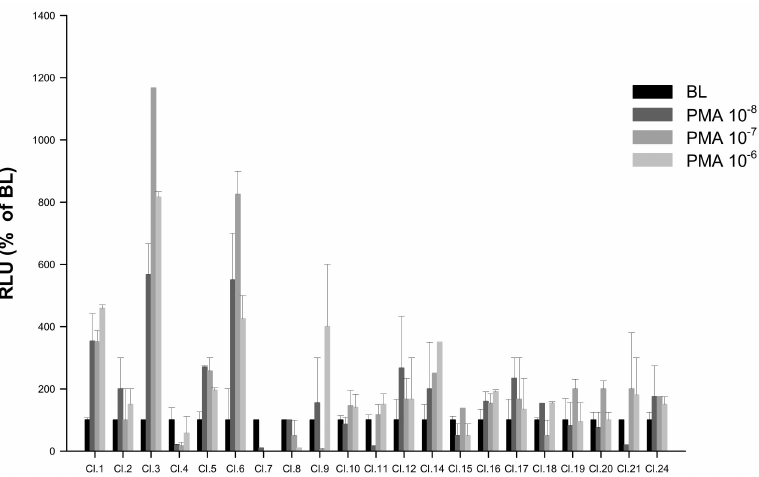
Figure 5. Screening of putative stable pGL3- NFAT -luc-HEK293 clones by response to PMA ( n = 4) at 10-fold serial dilutions tested over three concentrations (10 − 8 , 10 − 7 and 10 − 6 ). Evaluation of PMA responses was based on the RLU mean ± SEM of four independent determinations normalized to the mean response of the same transfections stimulated with assay medium (DMEM + 1% FBS). BL (Basal Levels) = 100% RLU. Clone 3 (Cl.3) was the most responsive to PMA-luminescence